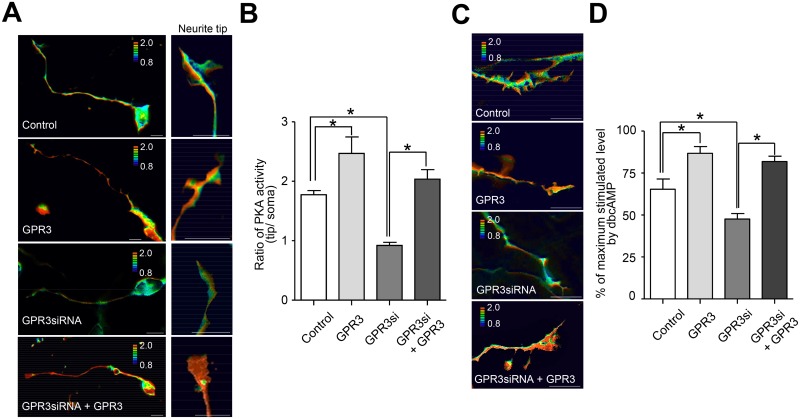
The local PKA activity was modulated by the expression of GPR3 in the CGNs.(A-B) The local PKA activity was compared between the soma and neurite tips in GPR3-transfected CGNs. The CGNs were transfected with Mock+control siRNA, pGPR3-HT+control siRNA, Mock+GPR3 siRNA, and pGPR3-HT+GPR3 siRNA, respectively. Forty-eight hours after transfection, the FRET/CFP images were captured using a fluorescent microscope. After capturing the images, the FRET/CFP intensity ratio was calculated and compared between the soma and neurite tips. (A) Representative FRET/CFP images from CGNs in each condition were shown (left raw). Magnifications of neurite tip were also shown (right raw) (B) The ratios of the PKA activity (tip to soma) in each condition were analyzed identically. The data represent the means ± SEM for each condition (n = 7). The asterisk (*) represents p < 0.005. (C-D) The PKA activity at the neurite tips was analyzed in CGNs transfected with Mock+control siRNA, pGPR3-HT+control siRNA, Mock+GPR3 siRNA, and pGPR3-HT+GPR3 siRNA, respectively. Forty-eight hours after transfection, the FRET/CFP images were captured using a fluorescent microscope. After capturing the images, the cells were treated with 1 mM dbcAMP for 15 min, and FRET/CFP images were captured again in the same cell to evaluated fully activated PKA. (C) Representative FRET/CFP images from the neurite tips of CGNs in each condition were shown. (D) The FRET/CFP ratio in each group were analyzed identically. The FRET/CFP ratios are expressed as the percentage of the maximum level stimulated by 1 mM dbcAMP in each cell. The data represent the means ± SEM for each condition (n = 9). The asterisk (*) represents p < 0.005.